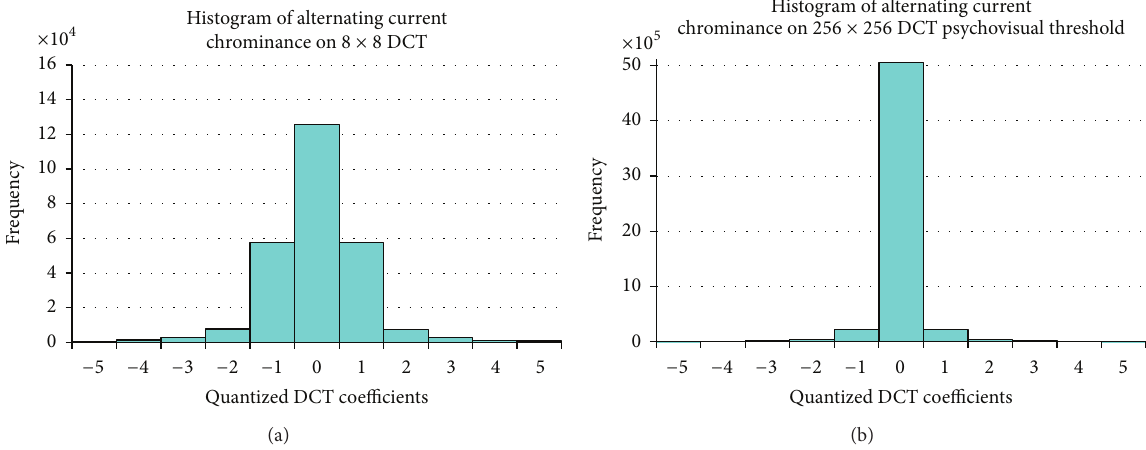
Figure 7: Frequency distribution of the alternating current (AC) coefficients using 8 × 8 default JPEG quantization tables (a) and 256 × 256 DCT quantization from psychovisual threshold (b) on chrominance for 40 real images.